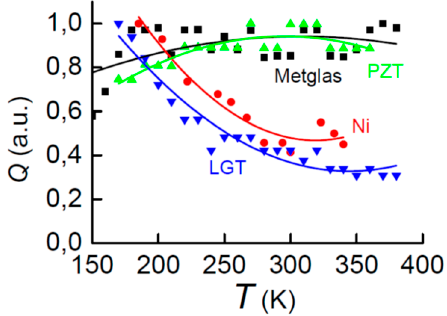
Figure 3. Temperature dependences of the normalized quality factor Q of PE and FM layers. Solid lines represent the approximation of data by a second-order polynomial.